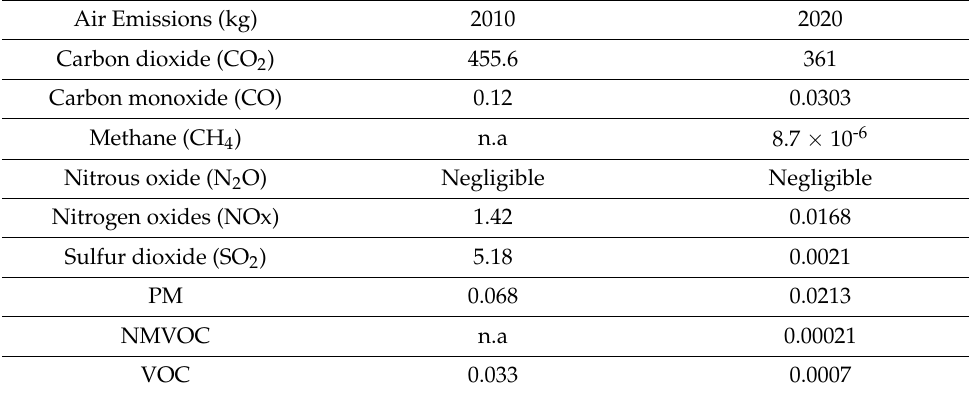
Table A2. Gate-to-gate LCI for 1